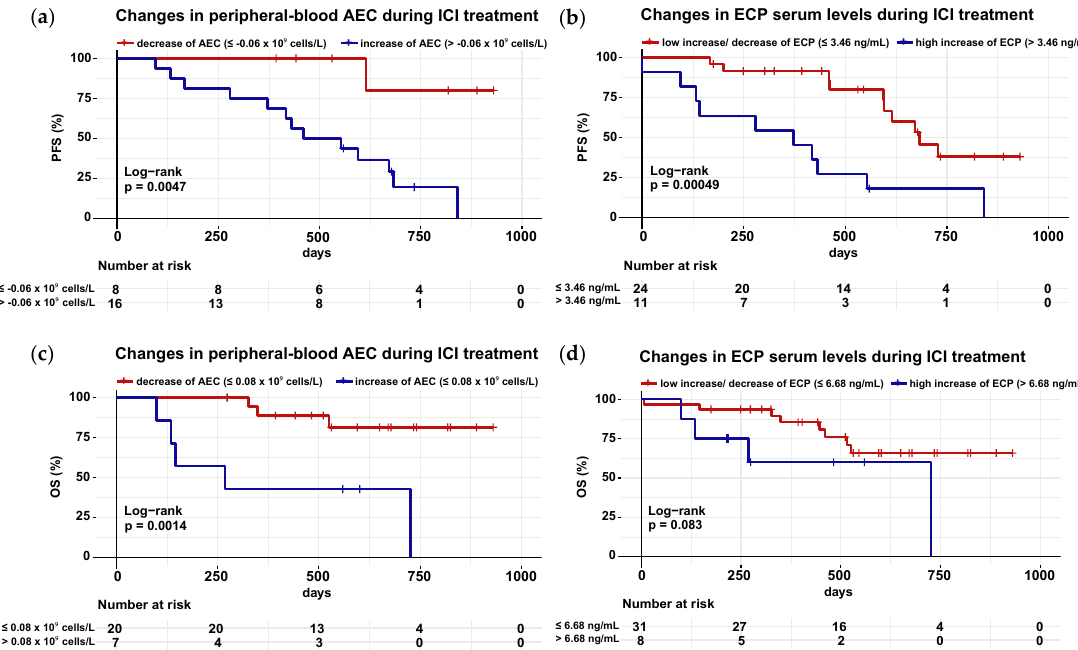
Figure 6. Decreasing peripheral-blood AEC, as well as constant to decreasing ECP serum levels between baseline and the fourth infusion cycle of ICI correlate with extended PFS and OS in met- astatic melanoma. For the kinetic analyses, the level of AEC and ECP before the fourth infusion cycle of ICI (C4) was subtracted from the corresponding level before ICI was initiated (baseline). Kaplan–Meier survival curves for PFS and OS of patients with advanced melanoma were stratified by the extent of the difference between baseline and C4 values of AEC and ECP in blood. p -values were calculated by the two-sided log-rank test; ( a ) Survival analyses for PFS of stage III and IV melanoma patients with decreasing (cut-off − 0.06 × 109 cells/L) AEC versus those with increasing AEC in peripheral blood between baseline and C4; ( b ) Survival analyses for PFS of stage III and IV melanoma patients with constant to decreasing (cut-off 3.46 ng/mL) ECP serum levels compared to patients with increasing ECP levels between baseline and C4; ( c ) Survival analyses for OS of stage III and IV melanoma patients with decreasing (cut-off 0.08 × 109 cells/L) AEC versus those with in-creasing AEC in peripheral blood between baseline and C4; ( d ) Survival analyses for OS of stage III and IV melanoma patients with low increasing to decreasing (cut-off 6.68 ng/mL) ECP serum levels compared to patients with high increasing ECP levels between baseline and C4. Abbreviations: AEC: absolute eosinophil count; ECP: eosinophil cationic protein; ICI: immune checkpoint inhibition; C4: 4th infusion cycle; PFS: progression-free survival; OS: overall survival; BE: baseline; p : p